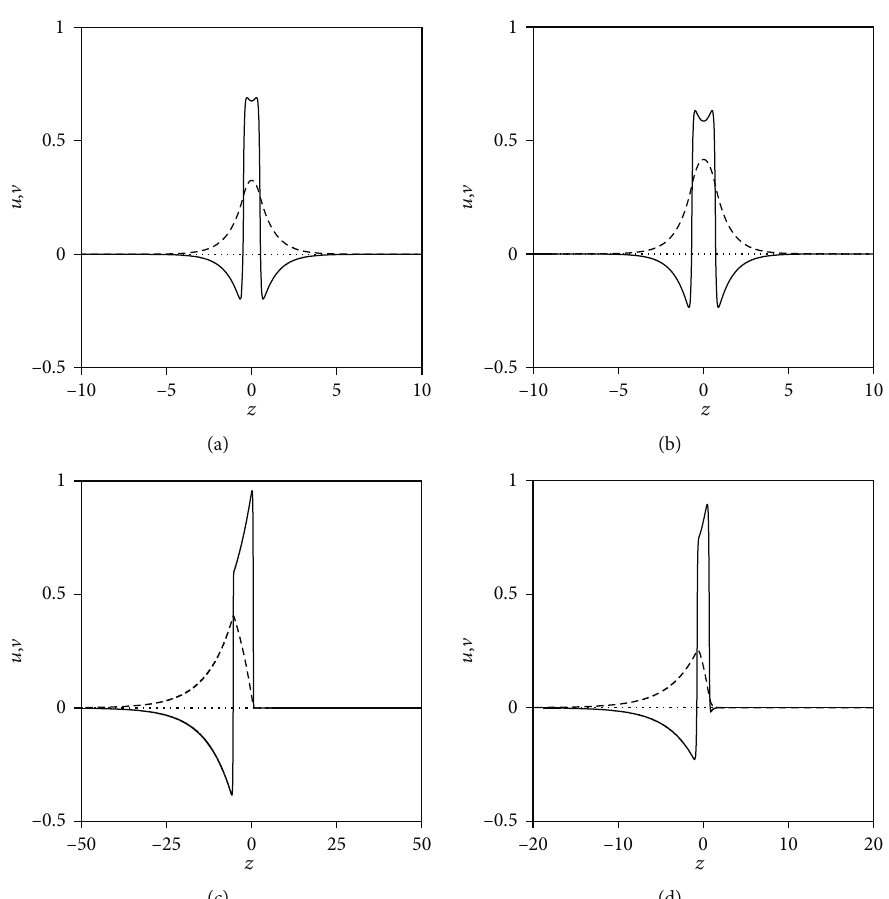
Figure 6: Pro fi les of the stationary pulse in a one-component RD equation with a convolution term (5) under periodic boundary conditions. Solid and dashed curves represent u and v , respectively. L = 5 0. (a) Standing pulse. τ = 0 .4, α = 0 , and c = 0. (b) Standing pulse. τ = 0 .4, α = 3 , = 1 .4, and c = 0. (c) Traveling pulse. τ = 0 .1, α = 0 , and c = 10. (d) Traveling pulse. τ = 0 .1, α = 3 , s s 0